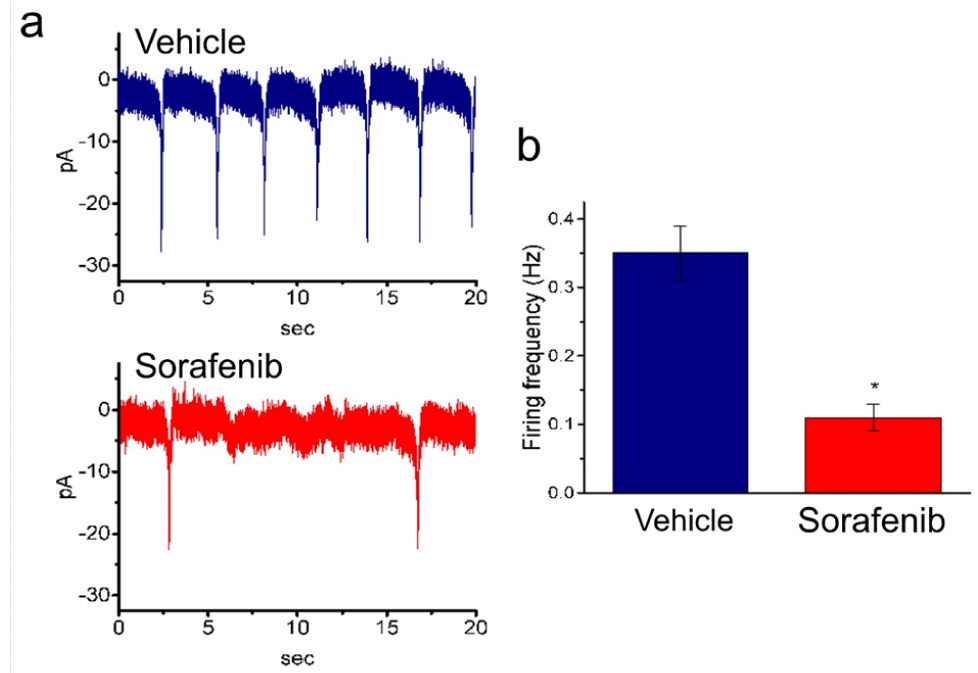
Figure 5. Action current (AC) firing recording in human-induced pluripotent-stem-cell-derived car- diomyocytes (hiPSC − CMs) with or without treatment of sorafenib. Prior to the electrophysiological experiments, hiPSC − CMs were incubated in 4 µ M sorafenib for 24 h. This set of experiments were conducted in cell-attached current recordings, and the potential was held at the level of the resting potential (approximately − 70 mV). ( a ) Representative current traces obtained in untreated ( a ) and treated ( b ) hiPSC − CMs. The downward deflection shows the occurrence of AC. ( b ) Summary bar graph showing the firing frequency of untreated and untreated cells (mean ± SEM; n = 7 for each bar). * Significantly different from untreated cells ( p <